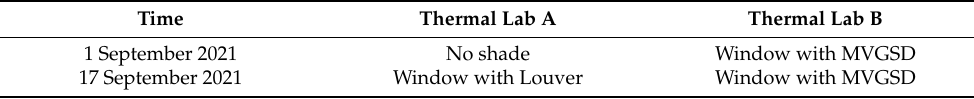
Table 4. Experimental conditions.